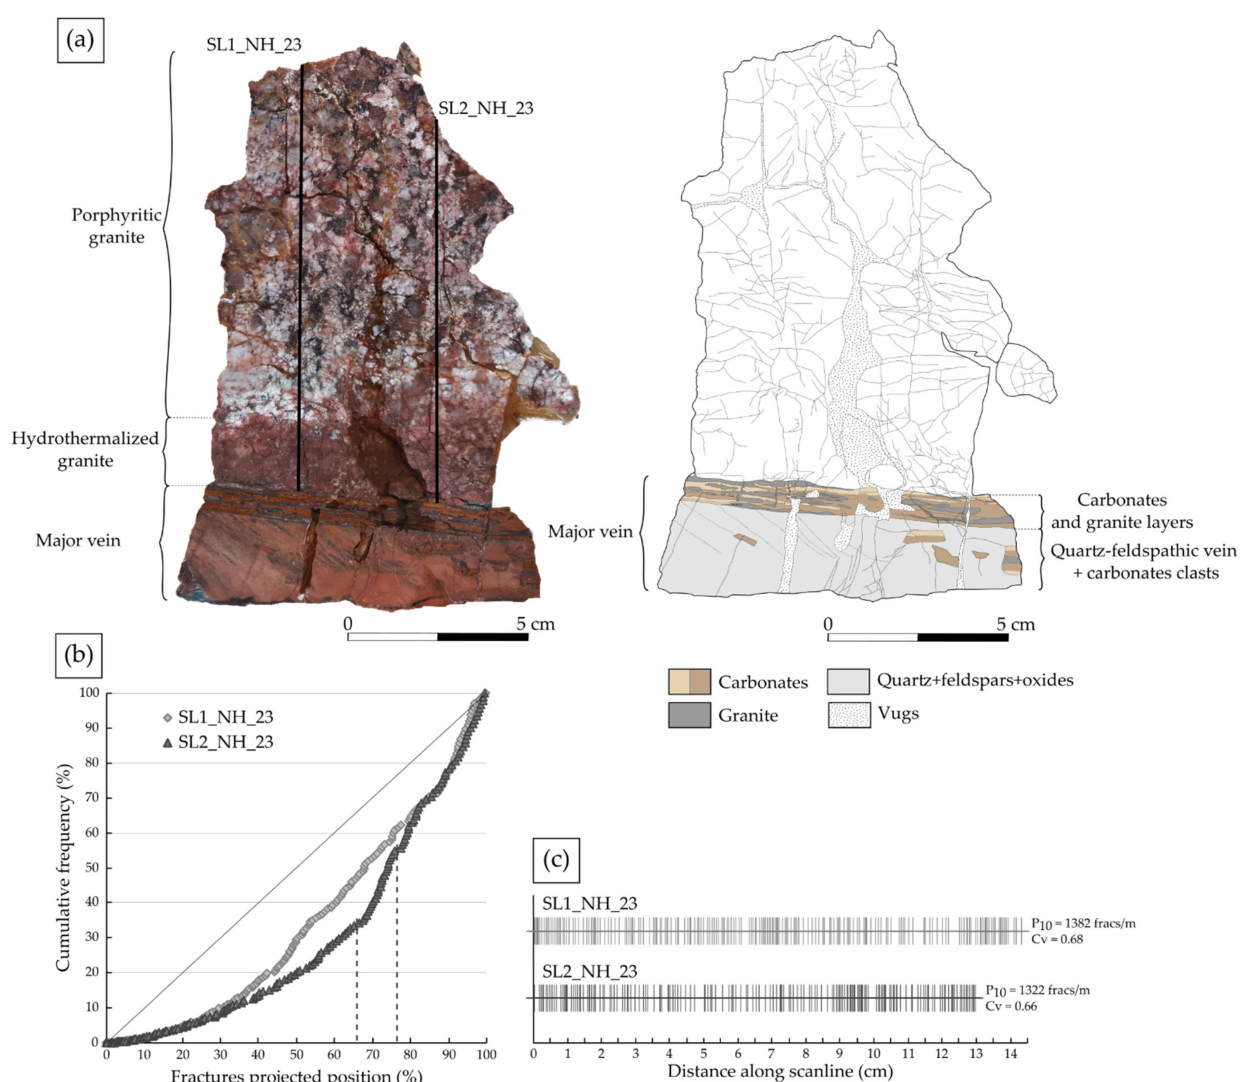
Figure 12. ( a ) A photo and the corresponding digitalization of the sample NH_23 showing the different compartments that compose it, as well as the two scanlines realized in the host rock of the vein. ( b ) Plots of the cumulative frequency percentage against distance percentage for both scanlines. The diagonal represents a uniform distribution. Dashed lines indicate a zone where a rapid increase of the number of fractures is observed (slope threshold >2). ( c ) Stick plots showing the fracture position along the scanlines and for which the fracture density (P 10 ) and the coefficient of variation (Cv) are